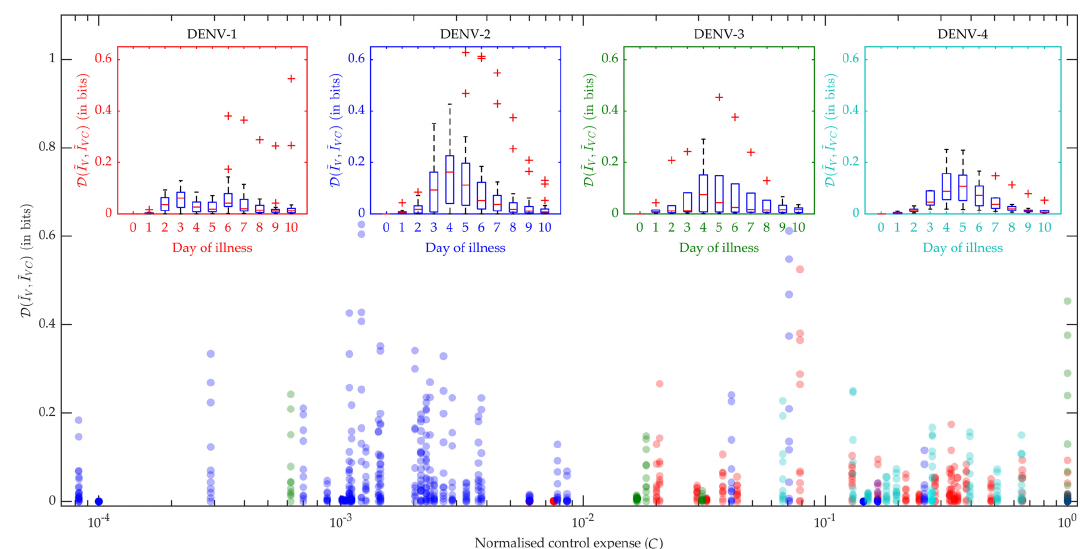
Figure 7. Control efficiency: The reduction in the human-to-mosquito virus transmission was evaluated by Jensen-Shannon (J-S) divergence ( D ), calculated between the distributions of the virus infected mosquitoes before (˜ I V ) and after (˜ I VC ) applying the optimal control. The box plot for each serotype explains the variation in the J-S divergence on each day of the febrile period (in the insets). The main scatter plot compares the efficiency of the applied optimal controls for different serotypes, in terms of J-S divergence versus normalised control expense ( C ) (red: DENV-1, blue: DENV-2, green: DENV-3, cyan: DENV-4). The control expense was computed by the area under the control curve